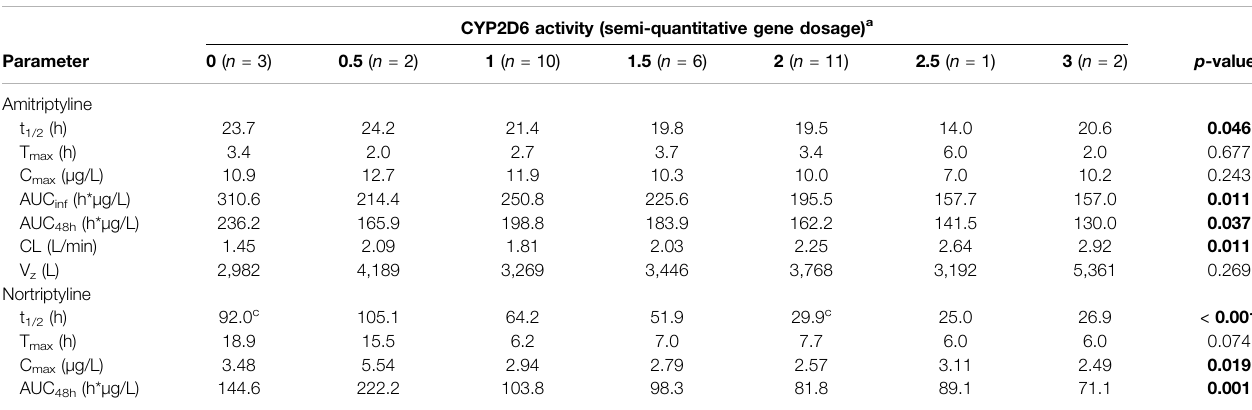
Data are shown as the mean. The study population was not selected based on their CYP2D6 genotypes. a The genotype-based CYP2D6 activity is based on the semi-quantitative gene dosage, as described earlier (Steimer et al., 2004). b Differences were analysed for statistical signi fi cance using the Jonckheere-Terpstra test. Signi fi cant values are highlighted in bold. c In 2 subjects carrying zero active CYP2D6 alleles and in one subjects with a CYP2D6 gene activity of 2, no decrease in NT concentration was observed and, therefore, no terminal elimination rate could be